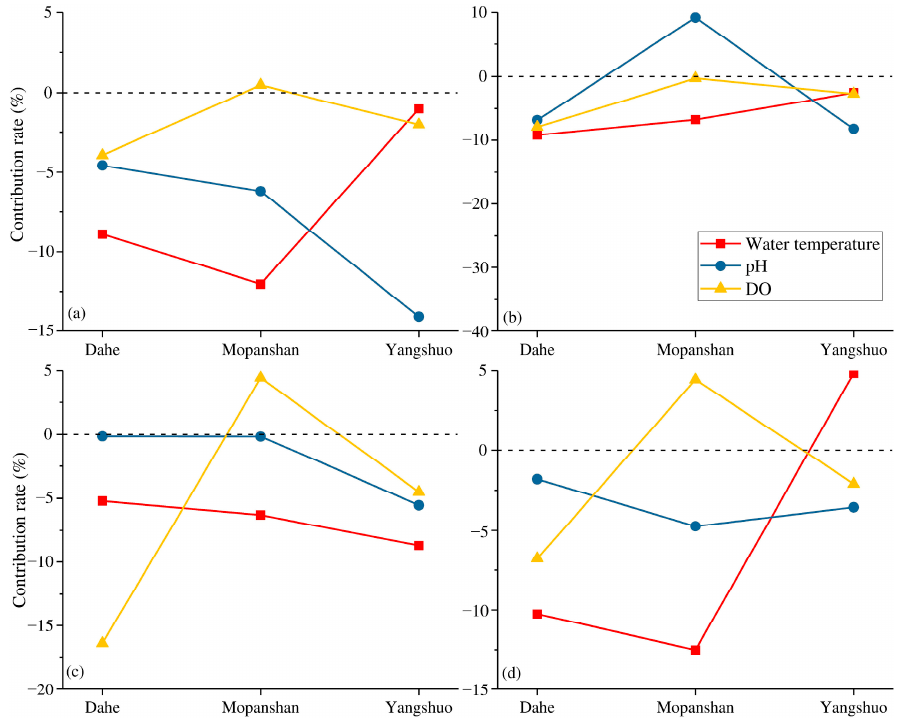
Figure 7. Changes in the contribution rate of environmental factors to water quality indicators in the Lijiang River, ( a ) NH 4 -N, ( b ) TP, ( c ) COD Mn , and ( d ) BOD 5 . NH 4 -N, TP, COD Mn , and BOD 5 are indicators for which lower values indicate better water quality. The DO in Mopanshan has a positive contribution to NH 4 -N, COD Mn , and BOD 5 , which means that an increase in DO will promote an increase in these three indicators. With the exception of the contribution rate of DO to NH 4 -N, which was only 0.47%, the other two indicators exceeded 4%. DO will clearly inhibit the growth of these indicators, as evidenced by Dahe and Yangshuo. However, DO in Mopanshan has a negative contribution to TP, and the contribution level is also significantly lower than that of Dahe. This result is primarily due to external pollution. First, the wastewater discharged from WWTPs in Guilin city has higher pollution concentrations [37], so pollutants increase as the Lijiang River flows through Guilin city. However, the confluence with the tributary Chaotian River increases the streamflow, promotes the exchange of water bodies, and increases the DO. However, the inflow of the Chaotian River could not eliminate the deterioration of water quality caused by Guilin city. The contents of DO and pollutants increased simultaneously, resulting in the positive